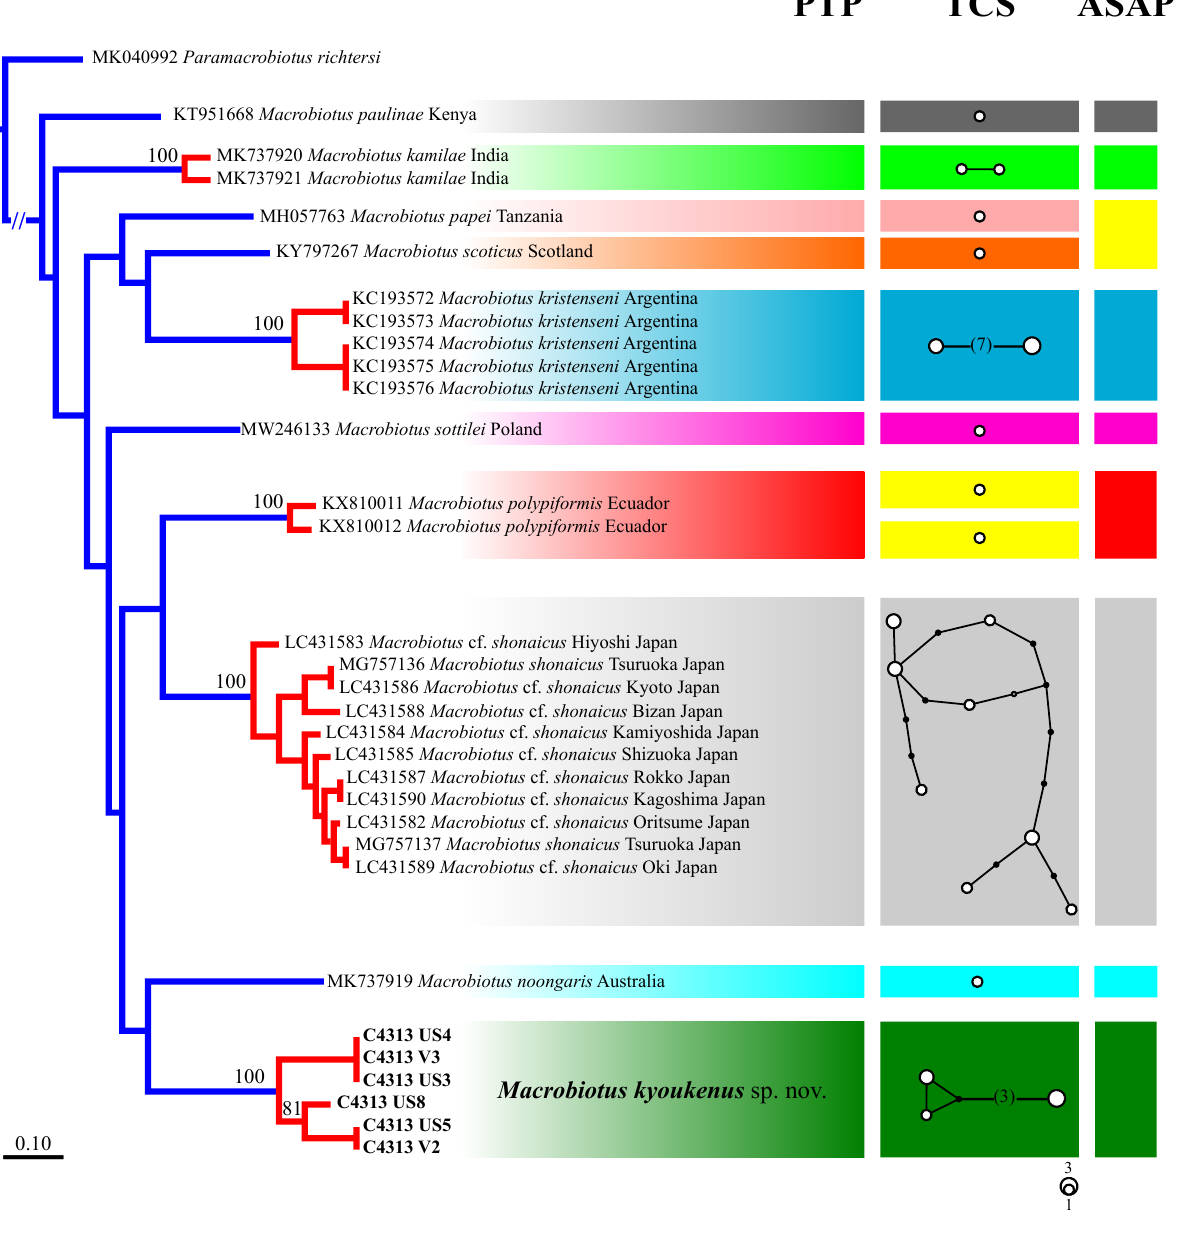
Figure 6. Species delimitation analyses based on 657 bp of the cox1 gene of Macrobiotus species pertaining to the subclade C, sensu [29]; ( left ) Tree resulting from the maximum likelihood analysis. Values above branches represent bootstrap values. Results of the Poisson tree process analysis are provided using differently coloured branches: putative species are indicated using transitions from blue-coloured to red-coloured branches. The scale bar shows the number of substitutions per nucleotide position; ( centre ) Haplotype network analysis. Circles denote haplotypes, while circle surface represents haplotype frequency. Black circles show putative/missing haplotypes. Networks falling below the value of the 95% connection limit are disconnected; ( right ) ASAP analysis shows different groups of specimens with the lowest asap-score (2.00) as indicated by rectangles. Discordances between delimitation results are highlighted in yellow. Newly scored haplotypes are in